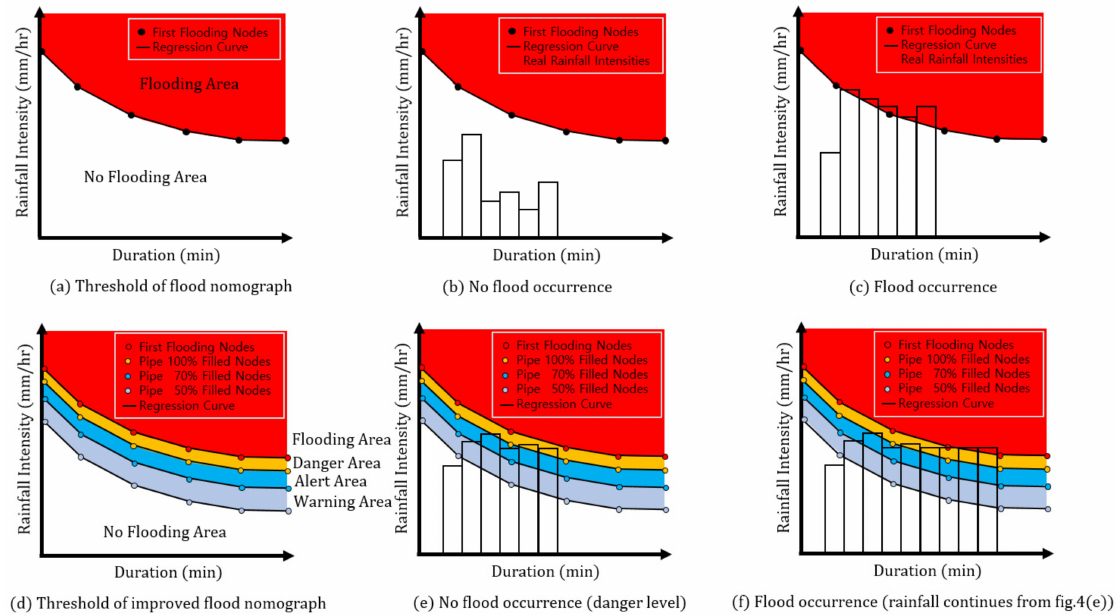
Figure 4. Schematic of improved flood nomograph in flood